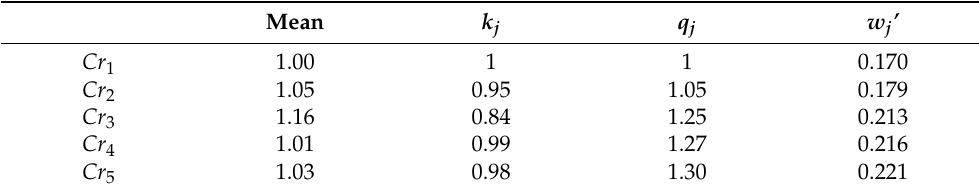
Table 14. The computational details and the criteria weights obtained using the PIPRECIA method based on mean